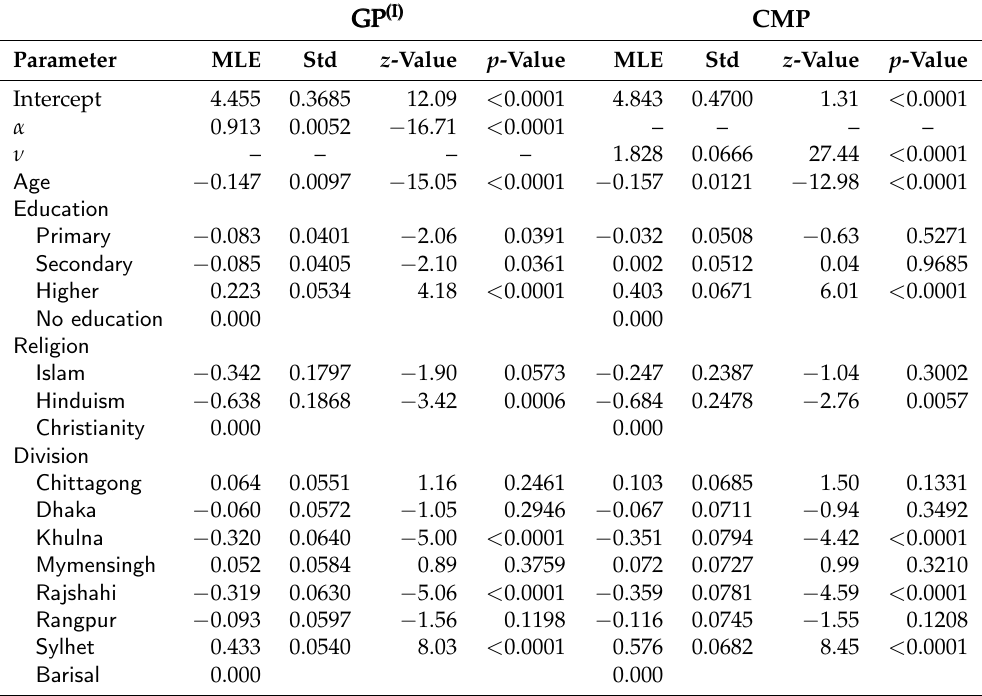
Table 10. MLEs and CIs of parameters for the GP (I) regression model in (21) and CMP regres- sion model.